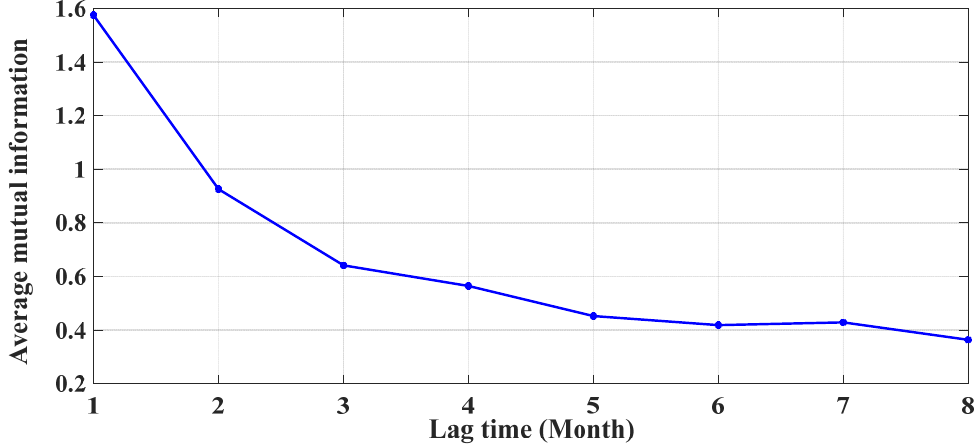
Figure 6. Average mutual information (AMI) function of the streamflow time